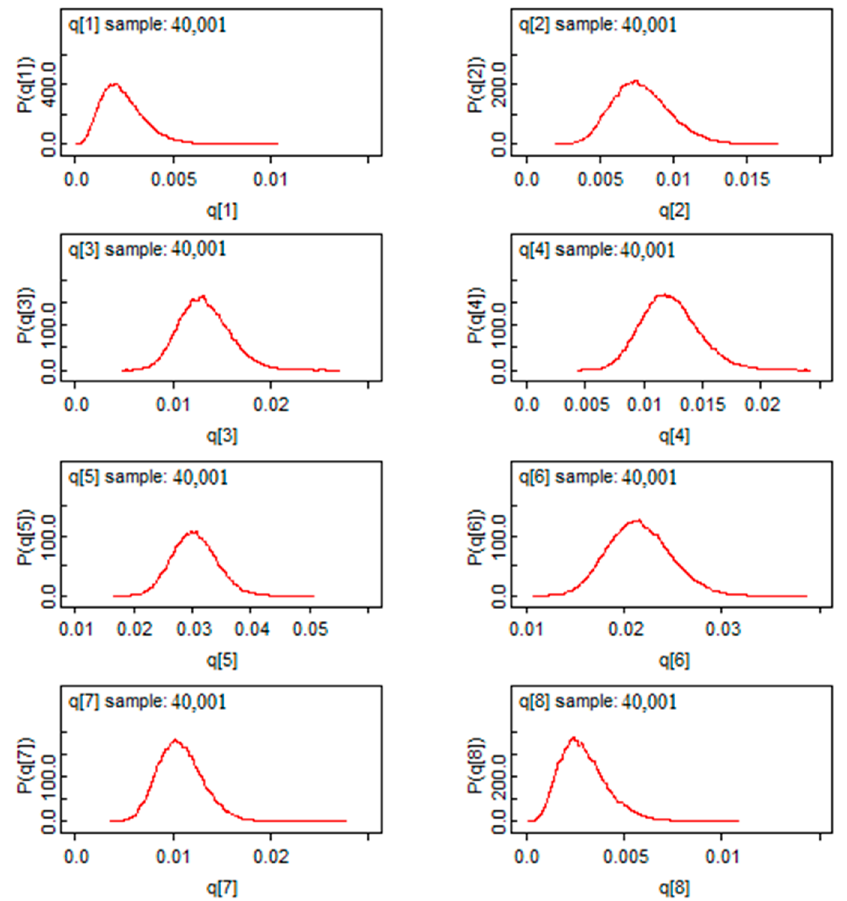
Figure 8. The post hoc risk distribution for the first 8 provinces.